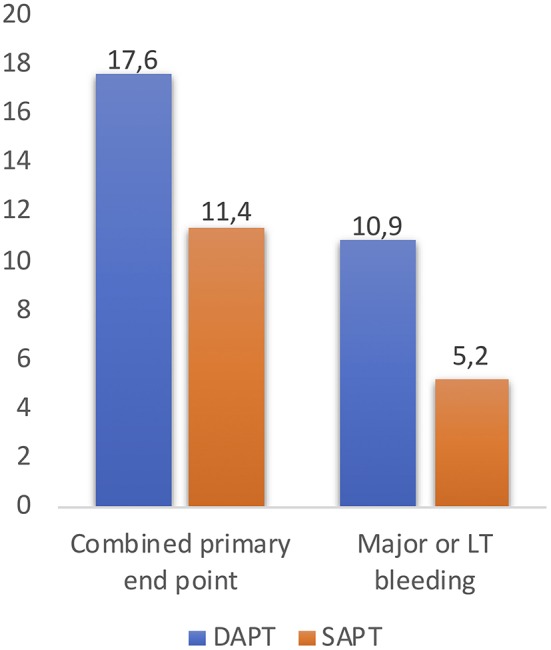
The occurrence of the 30-day combined primary end point (occurrence of death, major, or life-threatening bleedings, and major vascular complications at 30-day follow-up) and rate of major or life-threatening bleeding events after TAVR, reported in the study “Meta-Analysis Comparing Single vs. Dual Antiplatelet Therapy Following Transcatheter Aortic Valve Implantation (25).” DAPT, dual antiplatelet therapy; SAPT, single antiplatelet therapy; LT, life-threatening.